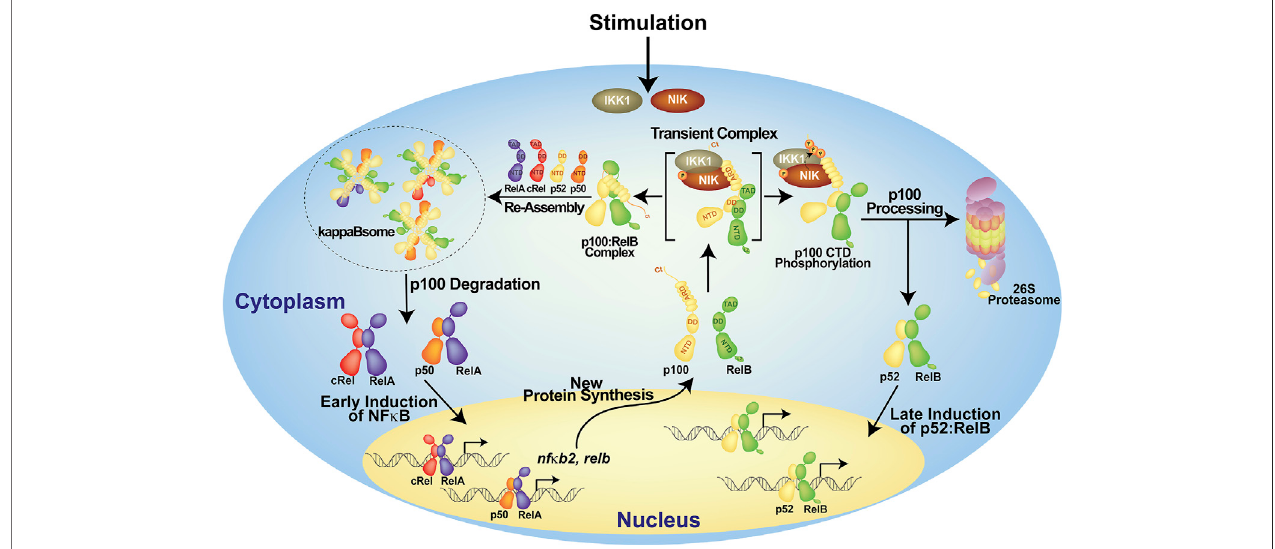
FIGURE 2 | A model of the generation of p52 from p100. In the resting cells, p100 forms high molecular weight complexes known as kappaBsomes; it inhibits nearly all NF- κ B subunits. Upon stimulation, p100 will be degraded resulting in the early induction of NF- κ B which in term activates nf κ b2 gene itself. The newly